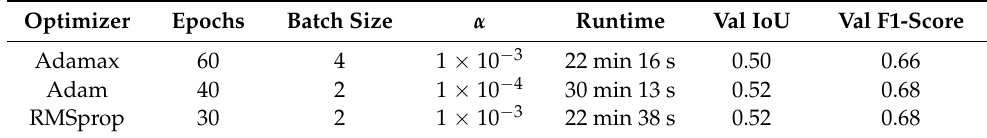
Table 5. Best hyperparameter configurations found by our BO optimization